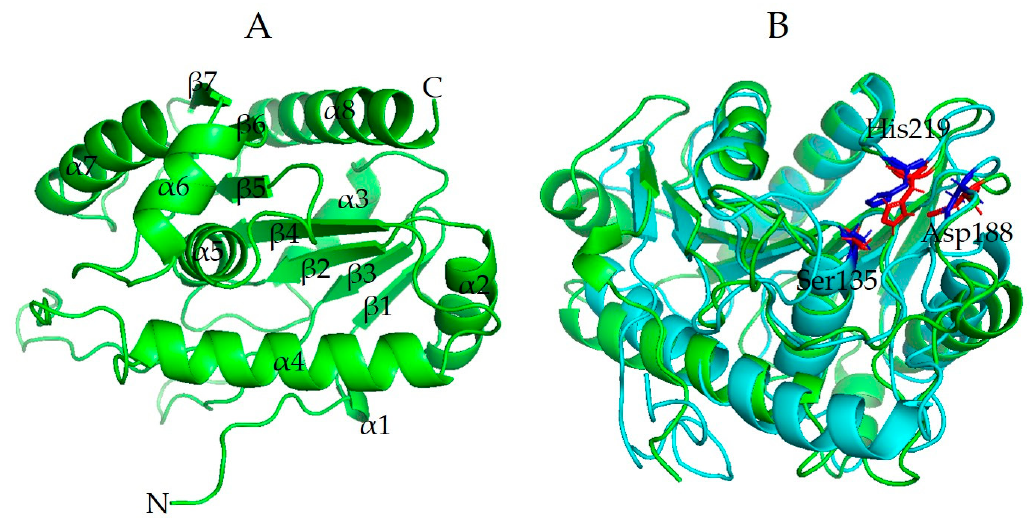
Figure 6. 3D structural modeling of Est6. ( A ) The rank 1 model of Est6 with eight α -helices and seven β -sheets predicted by AlphaFold2. ( B ) Superposition of the rank 1 model predicted by AlphaFold2 (in green) with the rank 1 model predicted by I-TASSER (in cyan). The putative catalytic triad, including Ser135, Asp188, and His219, are shown in red stick forms predicted by AlphaFold2 and in blue stick forms predicted by I-TASSER, respectively. PyMOL2 software was used to visualize and superpose the predicted 3D structural models.